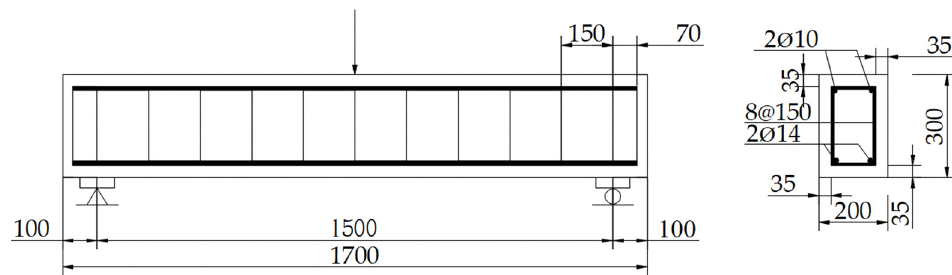
Figure 1. Geometric details of beam A (mm).